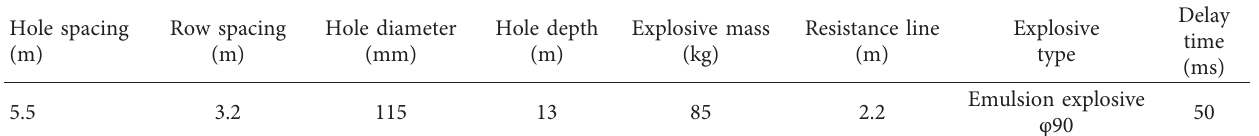
Figure 5: Surface rock blast vibration. (a) “Hualong No.1” foundation pit blasting project. (b) Vibration signal. Table 3: Parameters of rock